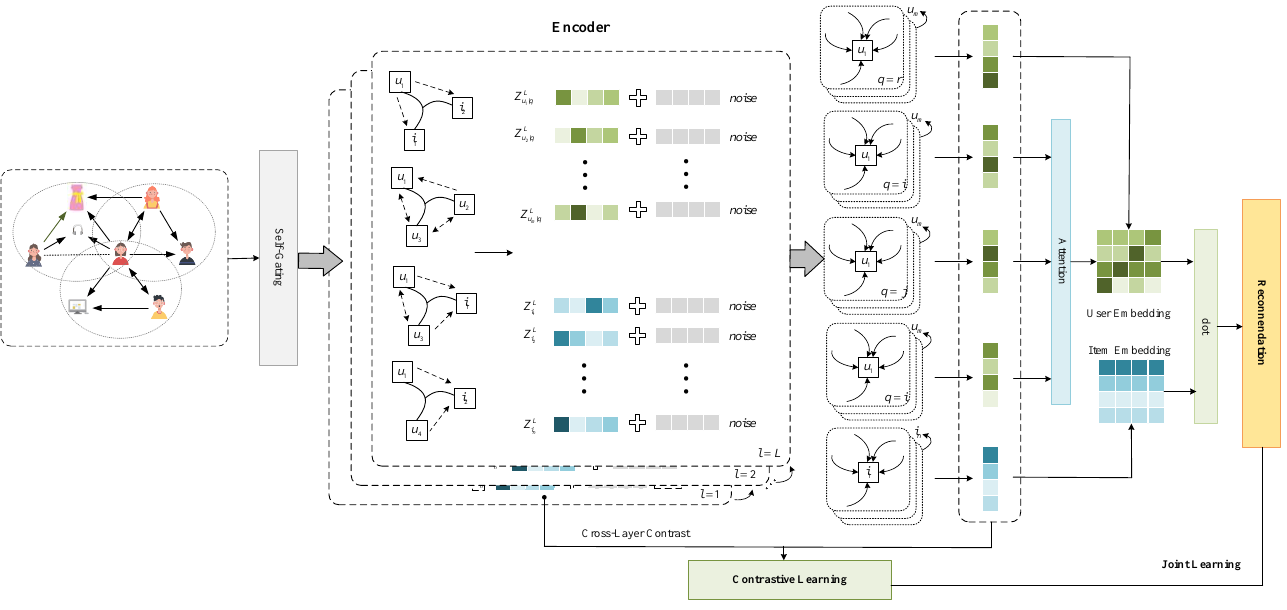
Figure 2. The overall system framework for GAFSRec.